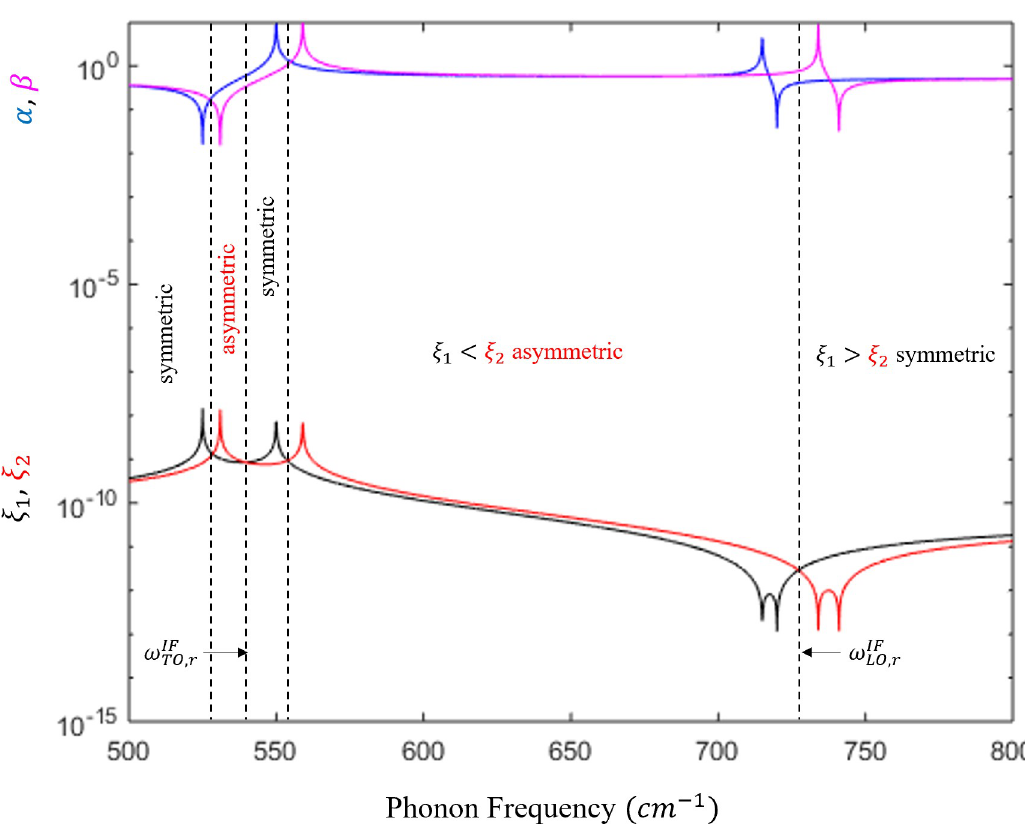
Fig 3. Parameters of the phonon wave function. ξ 1 and ξ 2 are indicated by black and red and α and β are indicated by blue and magenta. The vertical black dotted lines separate each symmetric and asymmetric region.